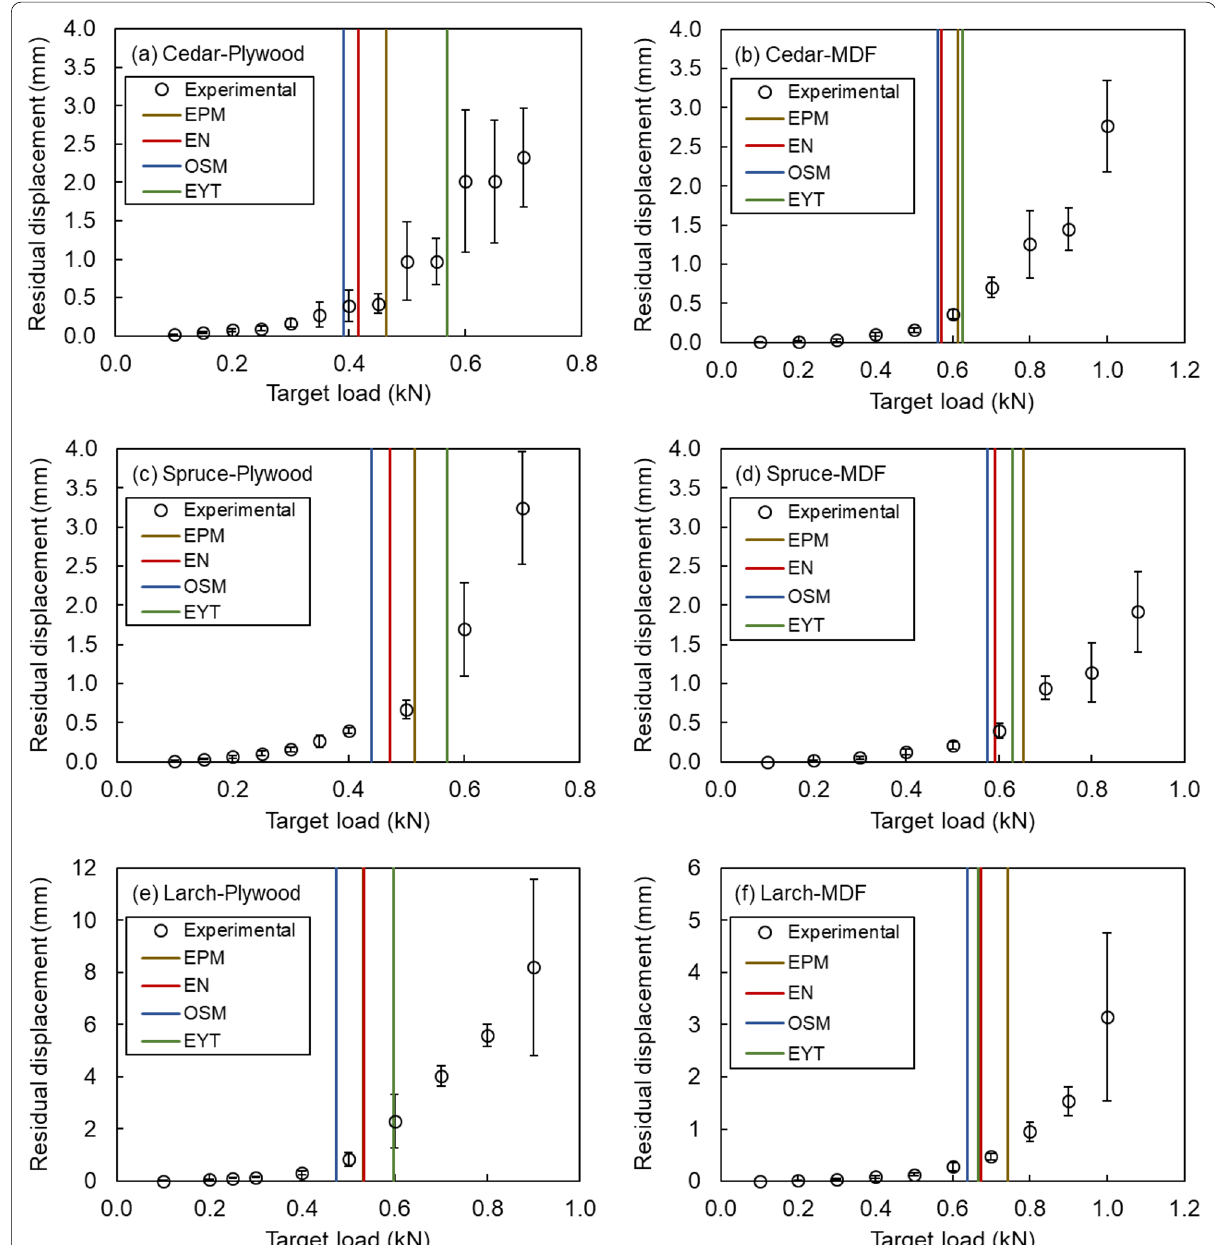
Fig. 7 Relationships between the residual displacement and target load per a nail. The plot and error bar indicate the mean value and standard deviation at each target load,